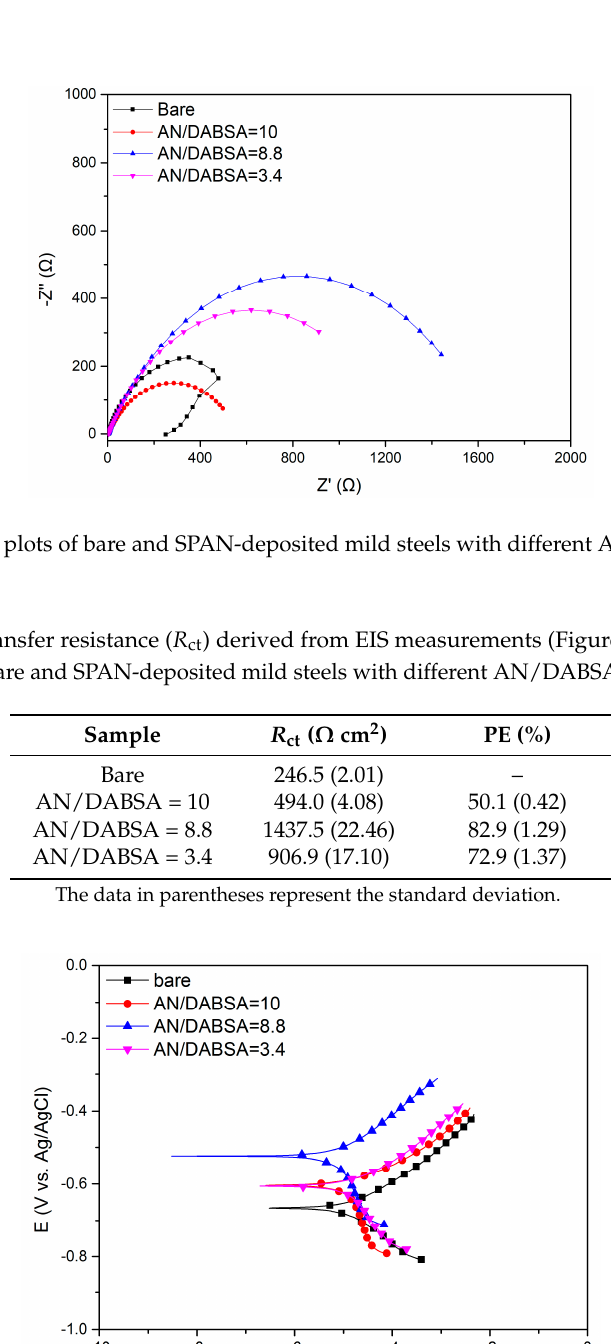
Figure 12. Polarization curves of bare and SPAN-deposited mild steels with different AN/DABSA ratios in 1 M NaCl. Table 4. Electrochemical parameters obtained by using polarization on bare and SPAN-deposited mild steels with different AN/DABSA ratios in 1 M NaCl.